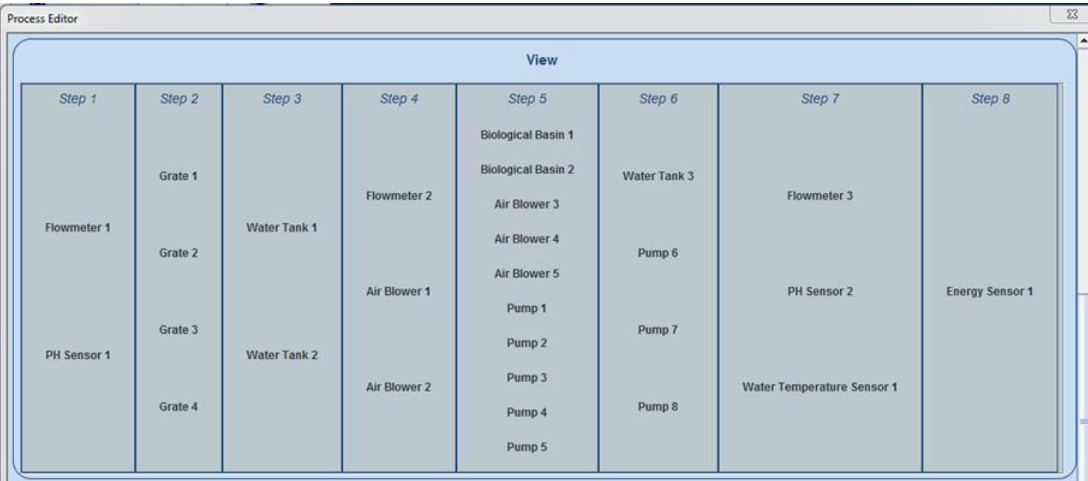
Figure 5. A process of a WWTP, as defined in the Historian Process Editor .